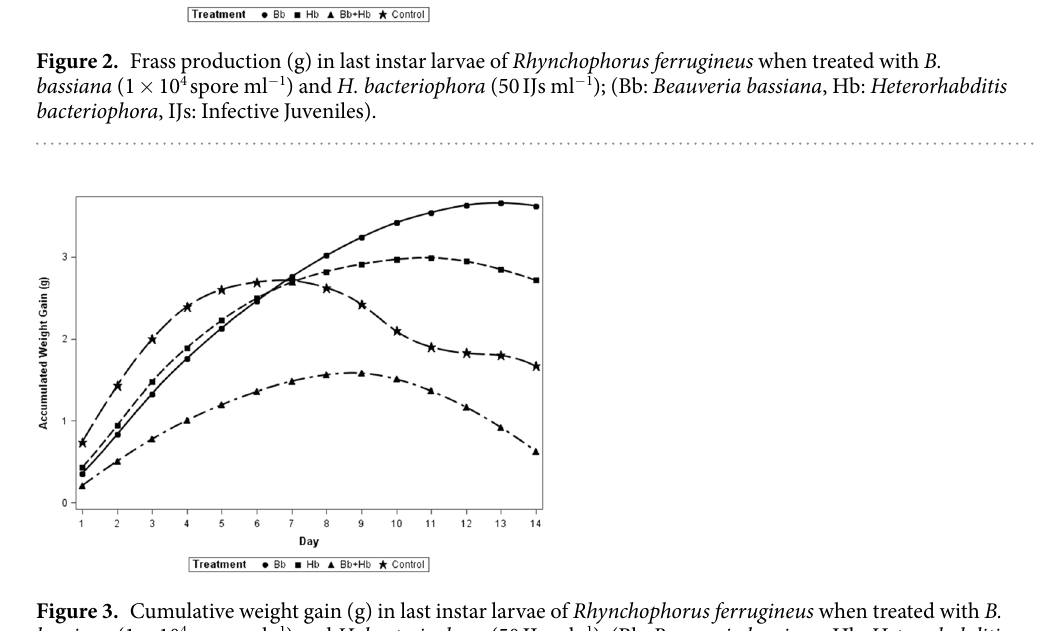
Figure 3. Cumulative weight gain (g) in last instar larvae of Rhynchophorus ferrugineus when treated with B. bassiana (1 × 10 4 spore ml − 1 ) and H. bacteriophora (50 IJs ml − 1 ); (Bb: Beauveria bassiana , Hb: Heterorhabditis bacteriophora , IJs: Infective